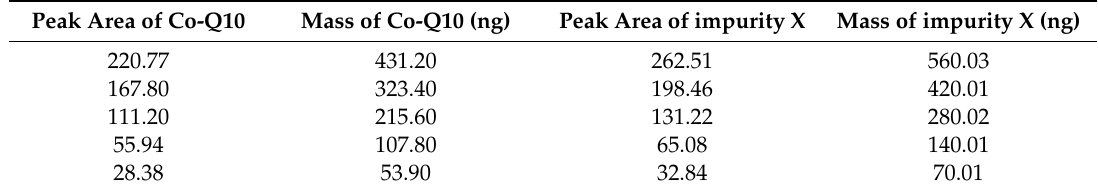
Figure 14. Typical chromatogram of mixed reference of impurity X (Left) and Co-Q10 (Right). Table 3. Correction factor for related substances.